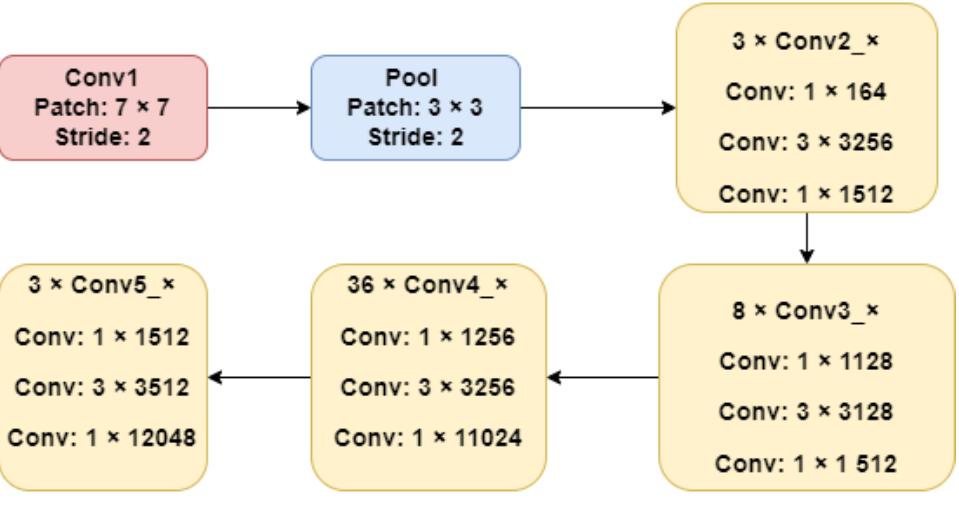
Figure 3. The model of the structure of ResNet